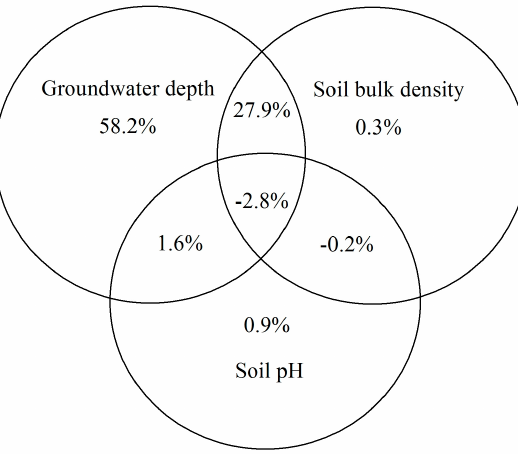
Figure 4. Variation partitioning of groundwater depth, soil bulk density, soil pH and their interactions in accounting for the variation of community characteristics. The numbers indicate the explanation percentage of variables and their interactions for variation.